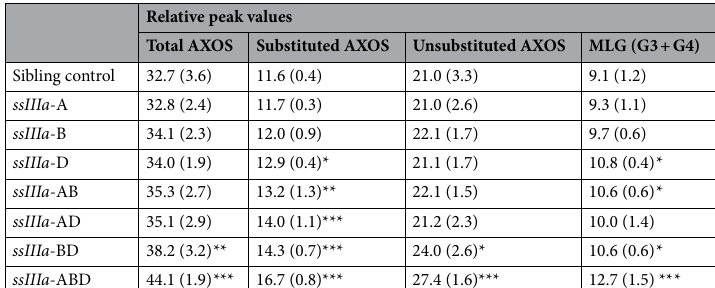
Table 3. Arabinoxylan oligosaccharides (AXOS) and mixed-linkage β-glucans (MLGs) in wholemeal flour of ssIIIa mutants and sibling control. Values were calculated as the sum of peaks relative to the internal standard and represent the mean and (standard deviation) for n = 5 biological replicates. MLGs were calculated by summing G3 + G4, the two major β-glucan oligosaccharides released by enzymatic digestion. Significant P-values (P < 0.05) identified in regression models comparing mutant genotypes to the sibling control are indicated with an asterisk